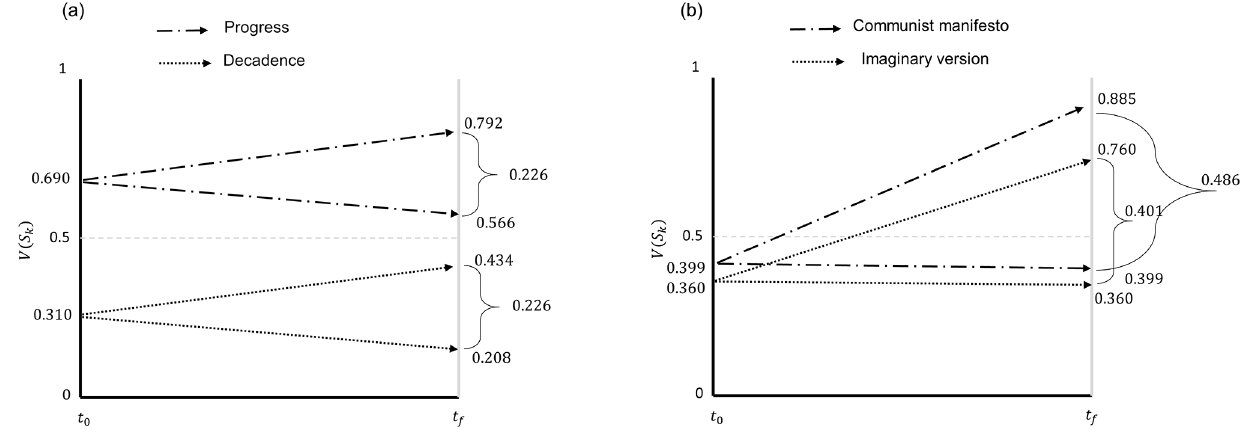
(a) Examples of Application of the CMPM in the Case of Contexts Where History Is Viewed as Progress or Where History Is Viewed as Decadence (See Main Text for the Vectors of Raw Values). (b) Application of the CMPM to the Communist